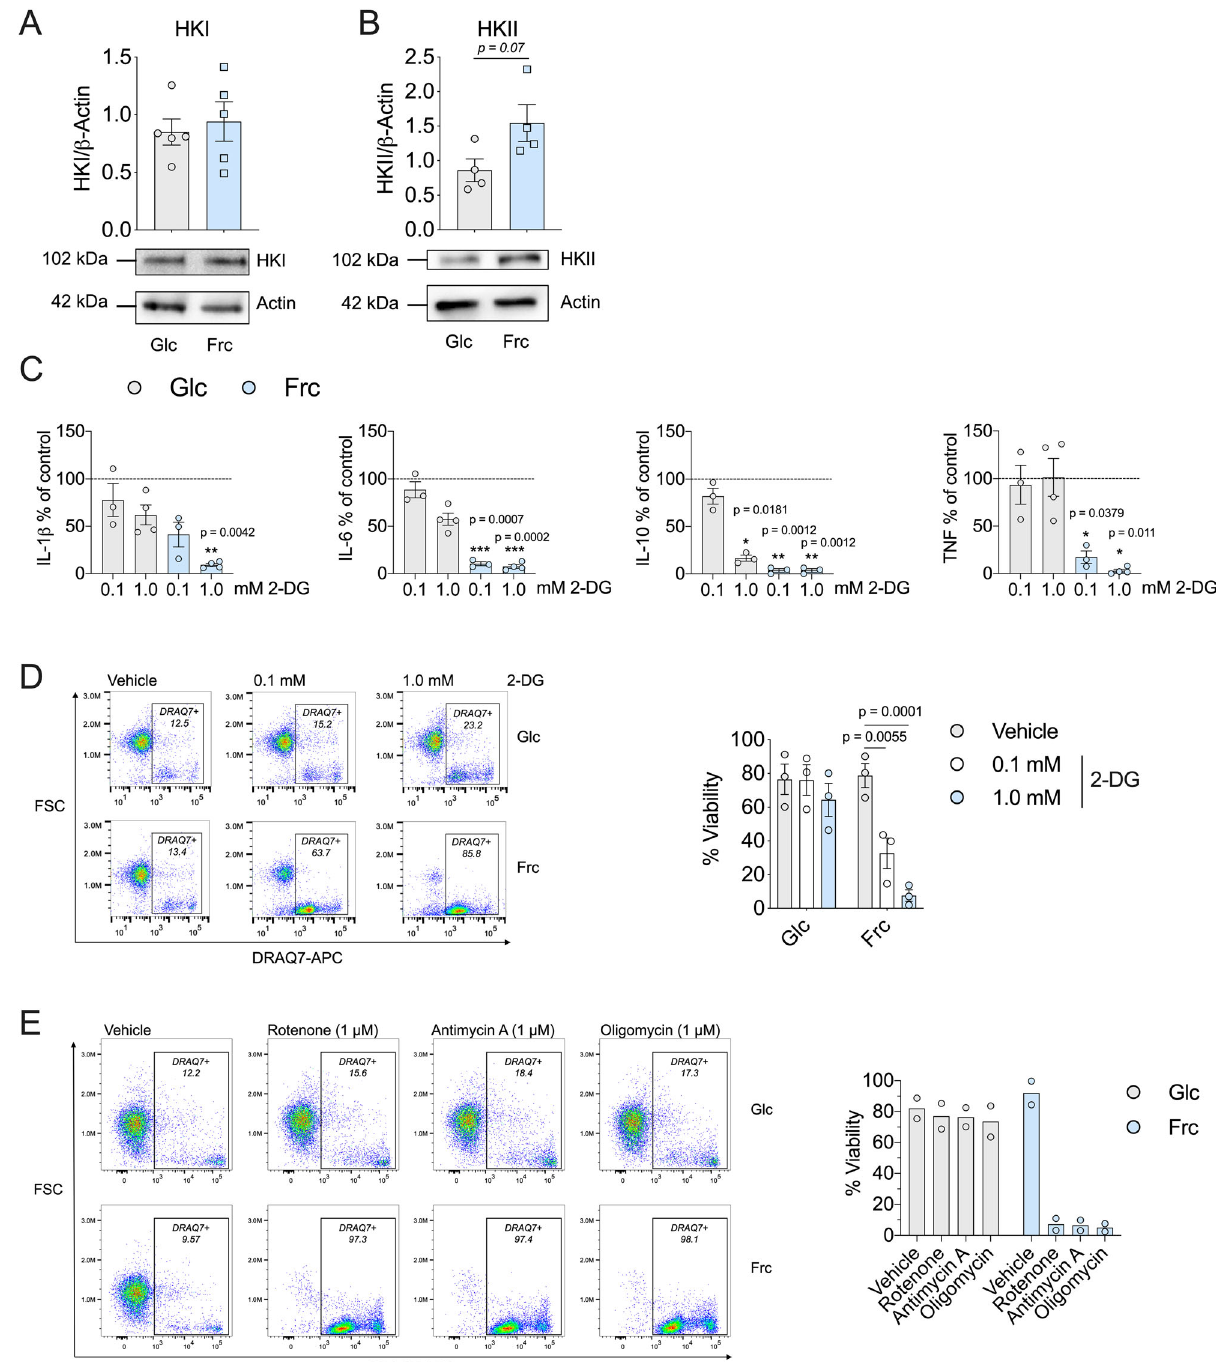
Fig. 6 Fructose-induced in fl ammatory monocytes are sensitive to metabolic inhibition. Immunoblot of LPS-stimulated monocytes in the presence of glucose or fructose with A hexokinase I or B hexokinase II analysed. C Cytokine release (% of control) of IL-1 β , IL-6, IL-10 and TNF (dotted line indicates control) and D representative fl ow cytometry plot including DRAQ7 viability of glucose or fructose LPS-stimulated monocytes in the presence or absence of glycolytic inhibitor, 2-DG (0.1 or 1.0 mM). E Representative fl ow cytometry plot including DRAQ7 viability of glucose or fructose LPS-stimulated monocytes in the presence or absence of complex I inhibitor, rotenone (1 µ M), complex III inhibitor antimycin A (1 µ M) or complex V inhibitor, oligomycin (1 µ M). Statistical signi fi cance was assessed using an unpaired, two-tailed t test ( A , B ) or a two-way ANOVA with Sidak ’ s multiple comparison test ( C , D ). Data are representative of fi ve ( A ), four ( B ), three – four ( C ), three ( D ) or two independent experiments ( E ) and are expressed as mean ± SEM; * p ≤ 0.05, ** p ≤ 0.01 and *** p ≤ 0.001. Source data are provided as a Source Data fi